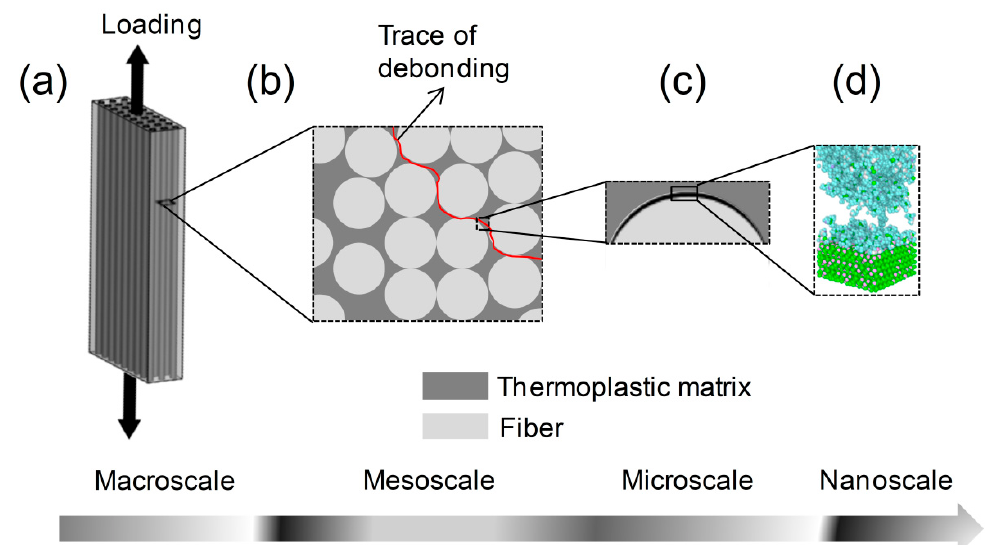
Figure 1. Structural hierarchy of damaged glass fiber reinforced thermoplastic composites from macro- to nanoscale: ( a ) macroscale composite sample; ( b ) mesoscale cross-section; ( c ) microscale fiber–matrix interface with size down to several nanometers; and ( d ) nanoscale interface with matrix molecule and amorphous SiO 2 .